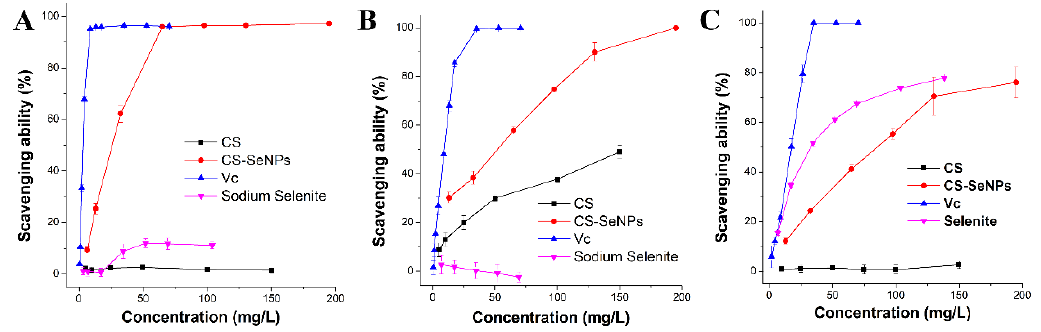
Figure 3. Free-radical scavenging activities against ( A ) DPPH ( • DPPH), ( B ) superoxide anion ( • O 2- ), and ( C ) hydroxyl ( • OH - ) radicals. Table 3. EC 50 of the free-radical scavenging ability (mg / L, n = 3) of the tested compounds. Free Radical VC Sodium selenite CS